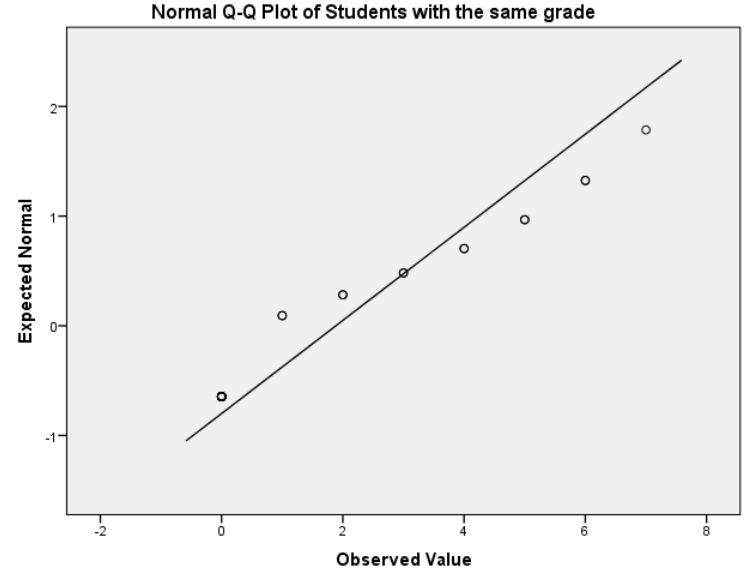
Figure 12. Q-Q plots test for normality assumption